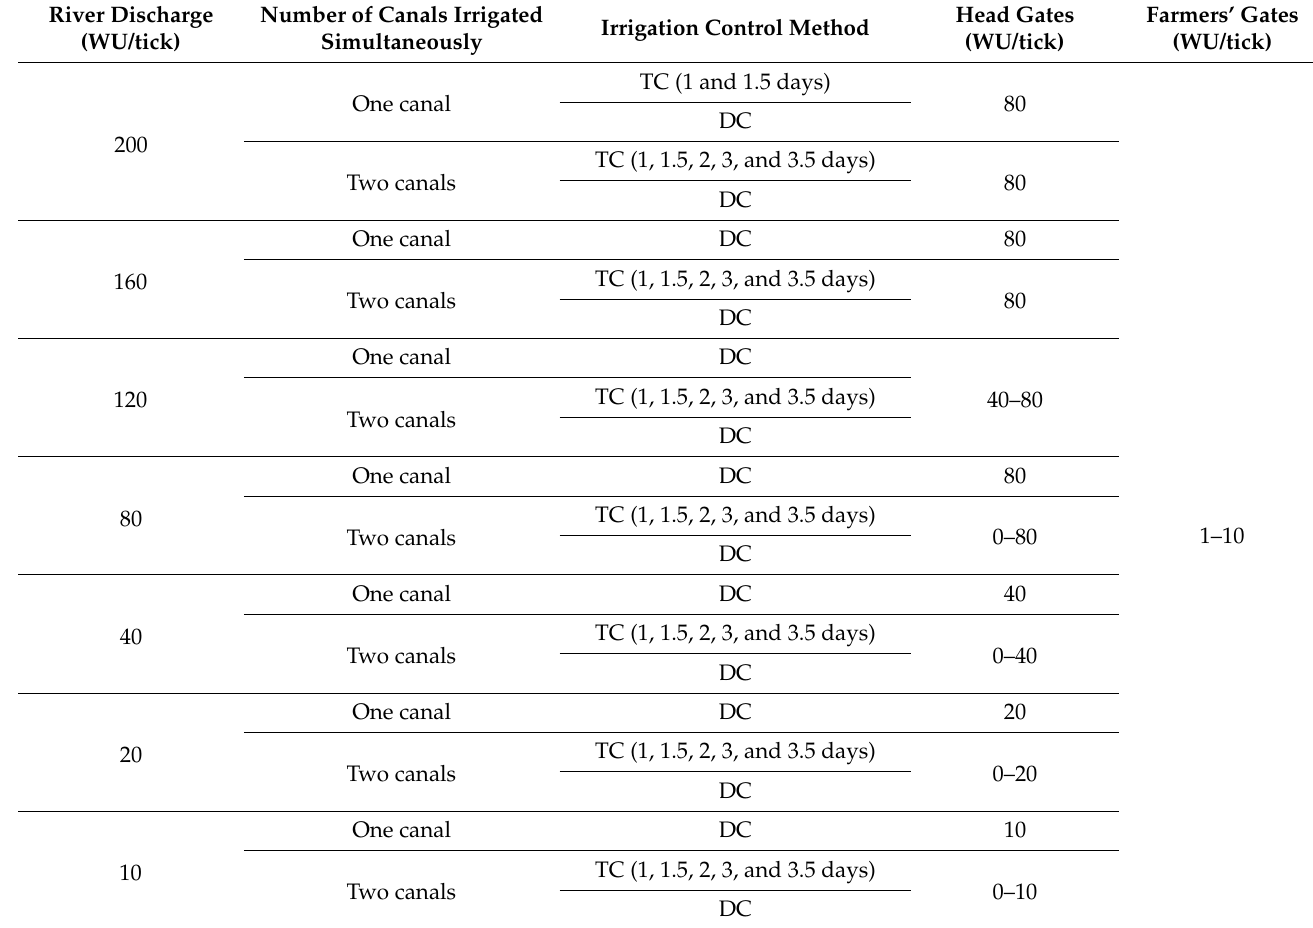
Table 1. Overview of the scenarios and parameter settings per